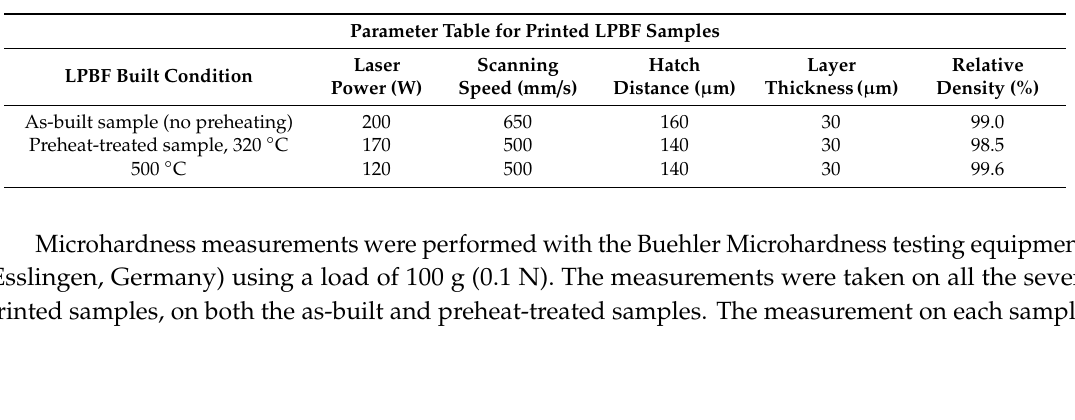
Figure 1. ( a ) Morphology of the gas-atomized particles with few satellites. ( b ) Particle size distribution (PSD) graph of the AlCu2.7Li1.8Mg0.3 alloy recording a d 50 of 40.5 µm. A Computer-Aided Design (CAD) test sample model of 5 × 5 × 10 mm 3 (Length × Breadth ×